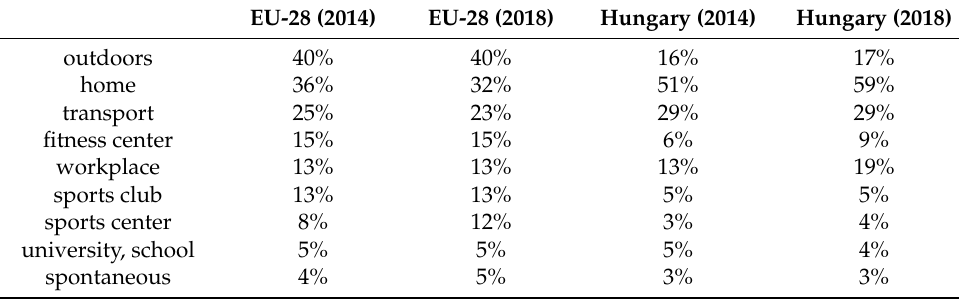
Table 3. Sports venue preferences in EU-28 and Hungary